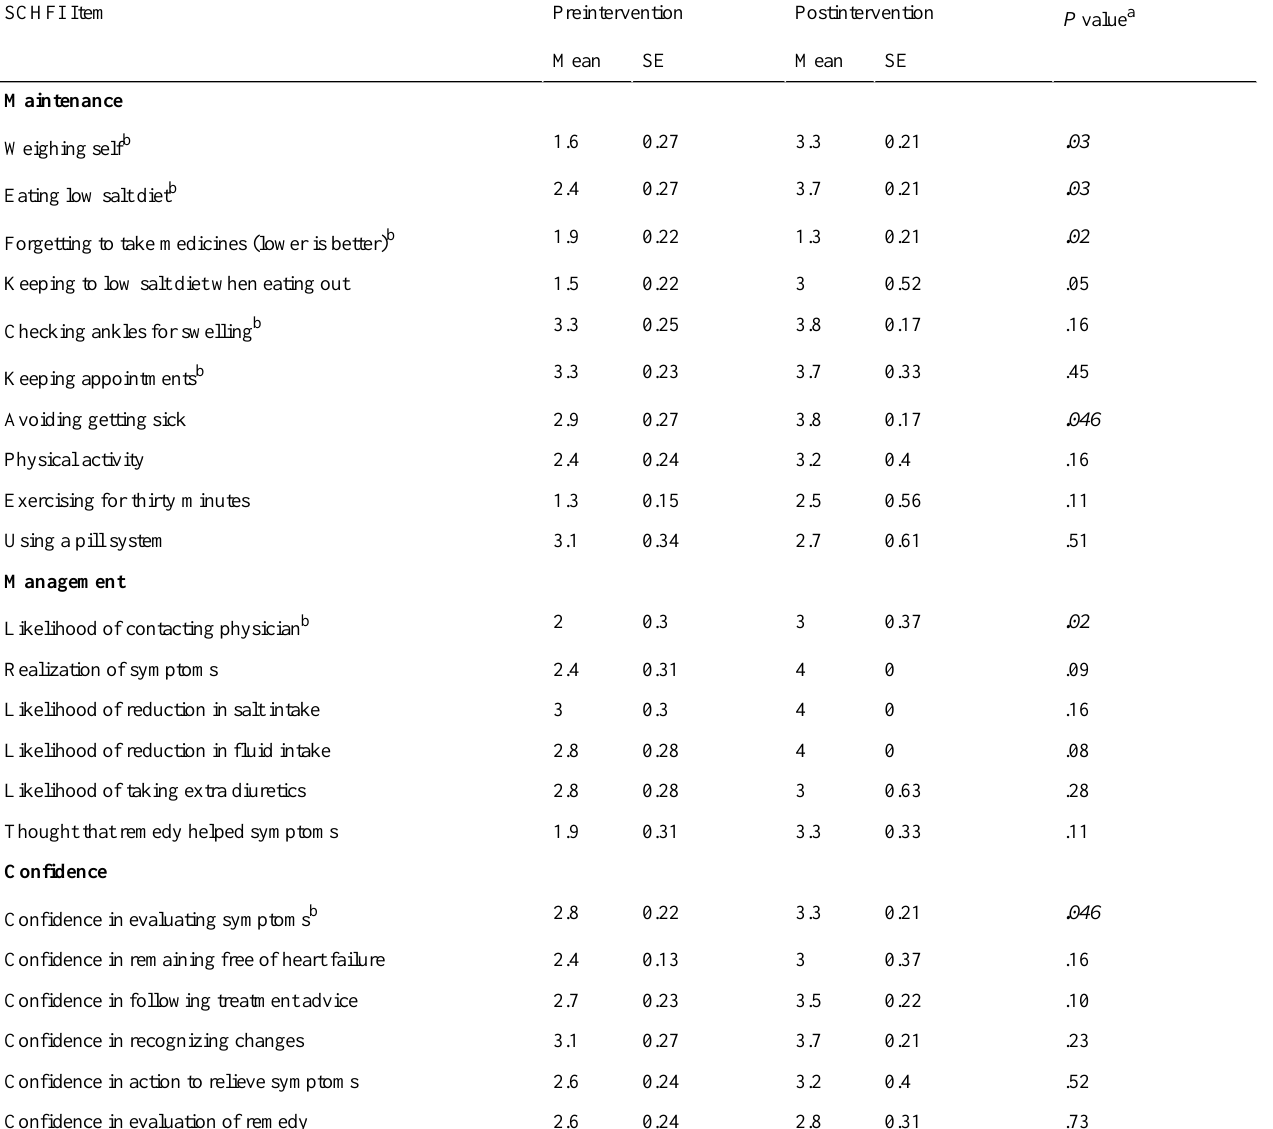
Table 5. Self-care Heart Failure Index (SCHFI) individual items preintervention and postintervention